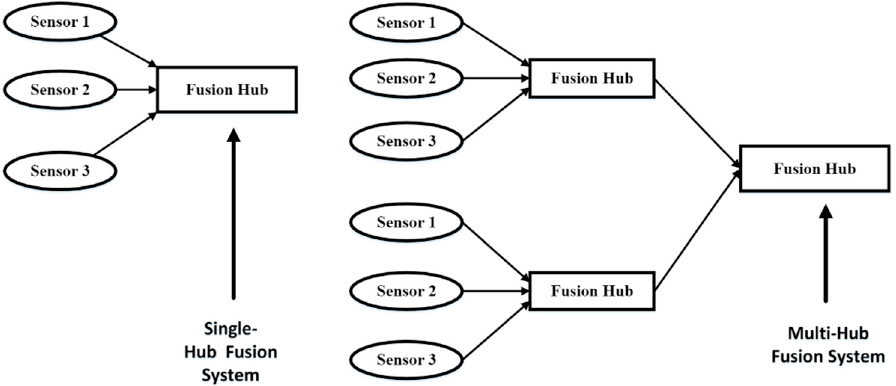
Figure 3. Levels of medical signal data fusion